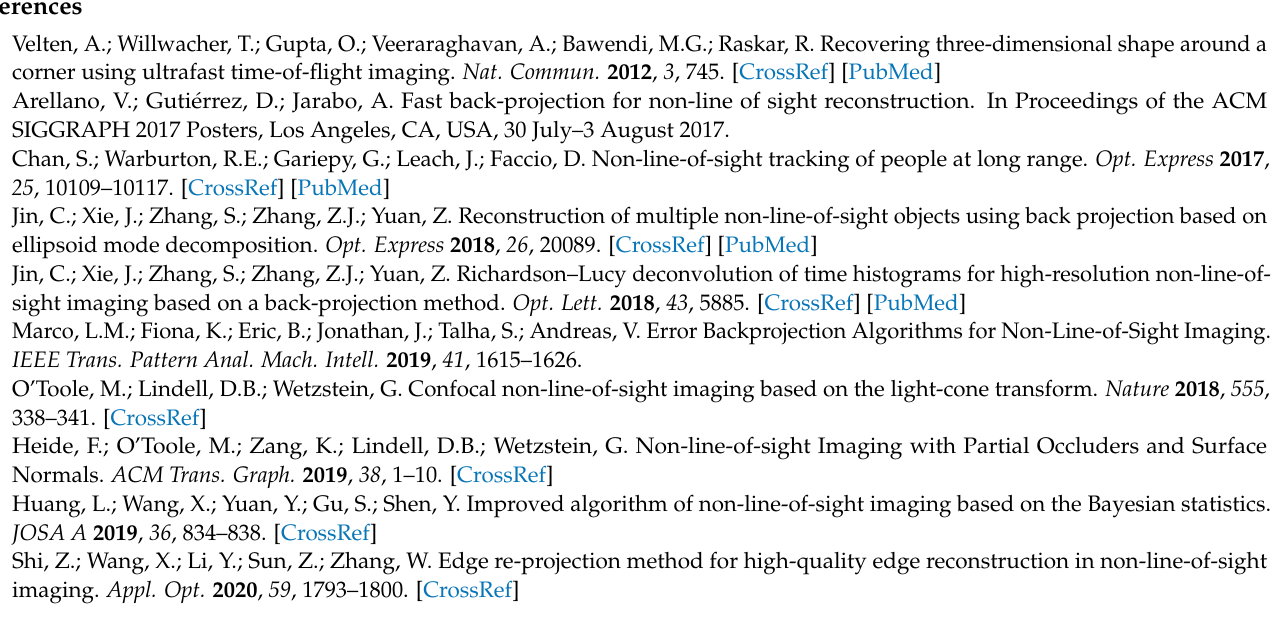
Figure S4: Reconstruction results on the simulated projection and simulated projection with added noise using JVC, RLS, SVD, and FISTA; Figure S5: Coordinate system of the NLOS scene setup; Figure S6: Close-range experiment results; Figure S7: Long-range experiment results; Figure S8: Comparison of the reconstruction results of the remaining test targets on the captured data; Table S1: Geometric parameters of the hidden target; Table S2: Geometric parameters of the camera FOV; Table S3: Geometric parameters of the laser scanning